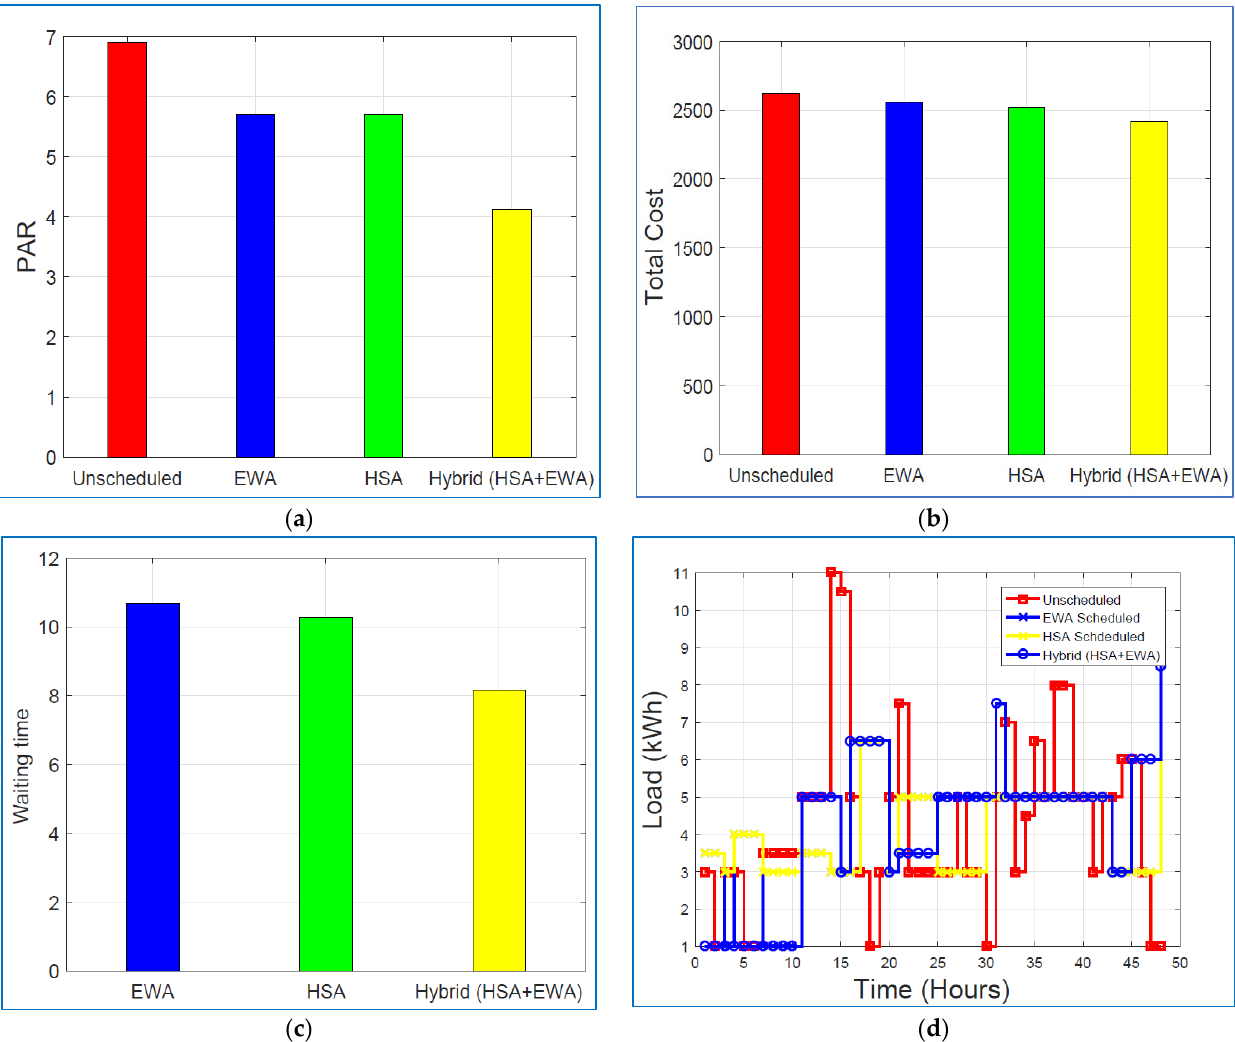
Figure 5. ( a ) 30 Minute OTI for PAR. ( b ) 30 Minute OTI for Total Cost. ( c ) 30 Minute OTI for User Figure 5. ( a ) 30 min OTI for PAR. ( b ) 30 min OTI for Total Cost. ( c ) 30 min OTI for User Comfort. Comfort. ( d ) 30 Minute OTI for Total Load. ( d ) 30 min OTI for Total